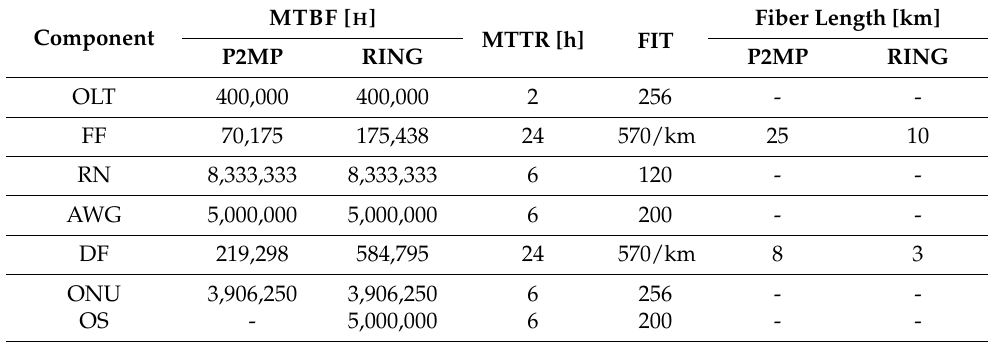
Table 3. Specific parameters’ values for components in WDM-PON networks.